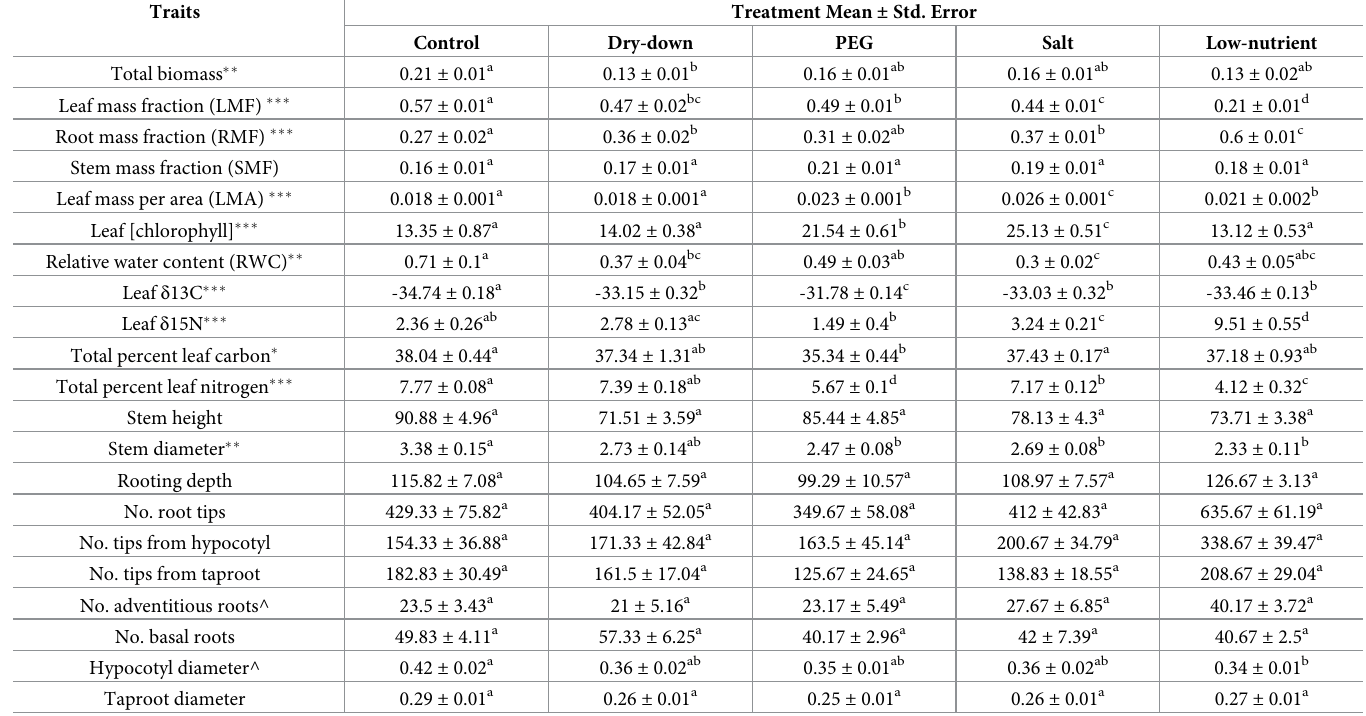
Superscript of asterisk and/or caret indicate significance of ANOVA effects, while letters indicate the post-hoc Wilcoxon groups. Significance for treatment effects indicated as: ��� P <